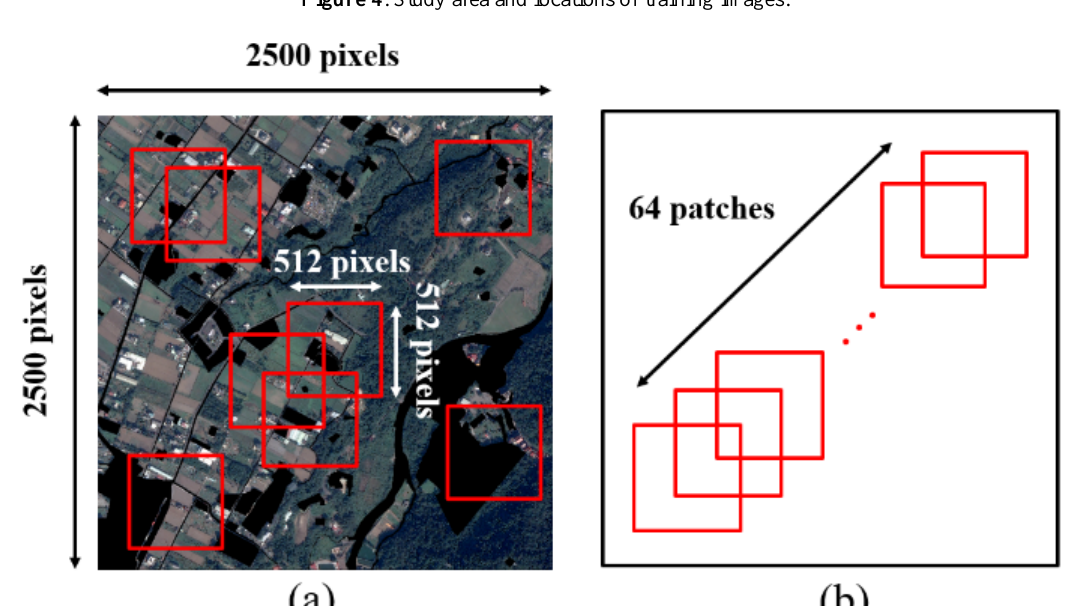
Figure 5. Illustration of patch and batch: (a) sub-image with several patches (in red frame); (b) a batch of 64 patches.